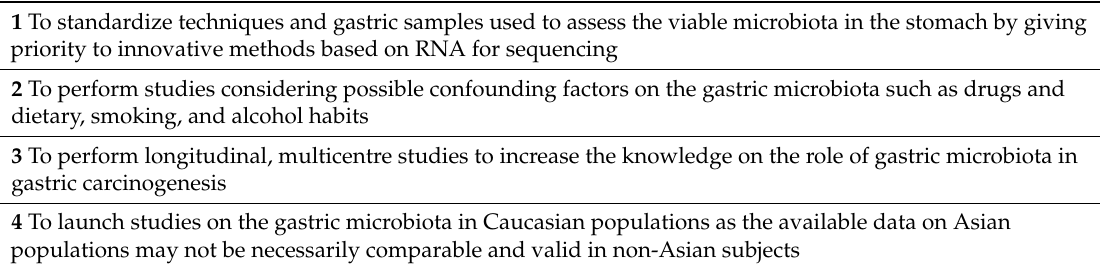
Table 1. Proposal of research agenda on gastric